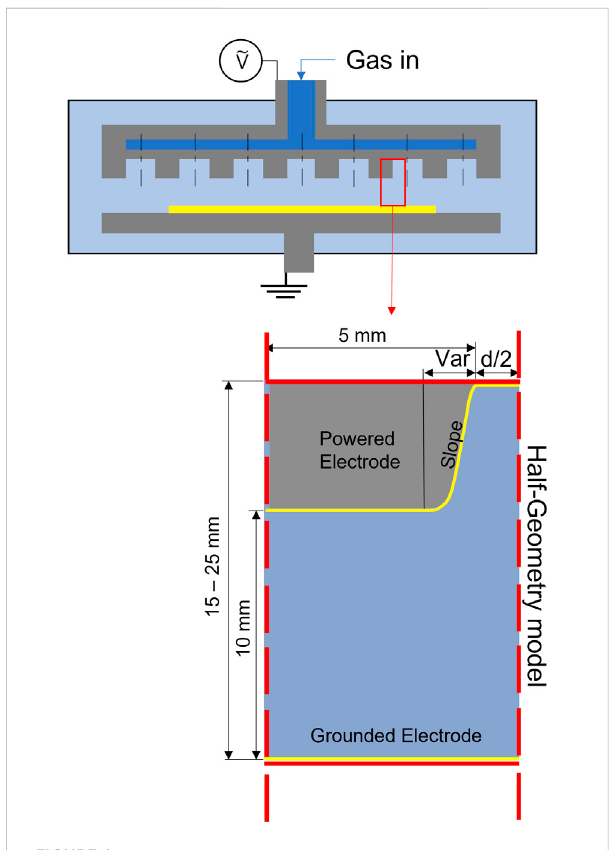
FIGURE 1 A schematic diagram of the simulation